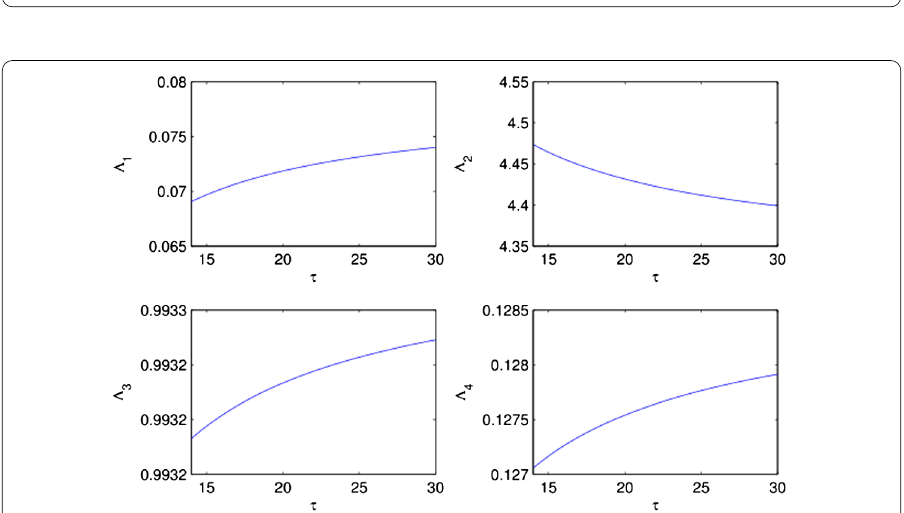
Figure 2 τ versus (cid:19) 1 , (cid:19) 2 , (cid:19) 3 , (cid:19) 4 have been plotted, where all the (cid:19) 1 , (cid:19) 2 , (cid:19) 3 , (cid:19) 4 are positive and τ ≥ τ 0 =